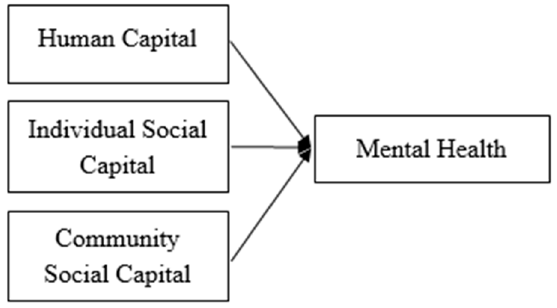
Figure 1. Research Figure 1. Research model.